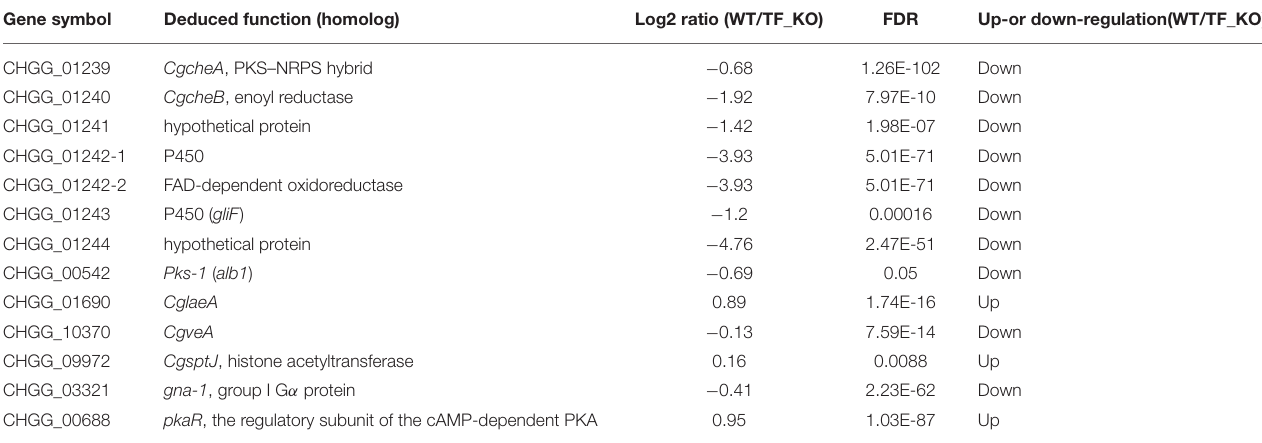
TABLE 1 | Expression variation of genes putatively related to ChA biosynthesis detected by RNA-seq profiling. Gene